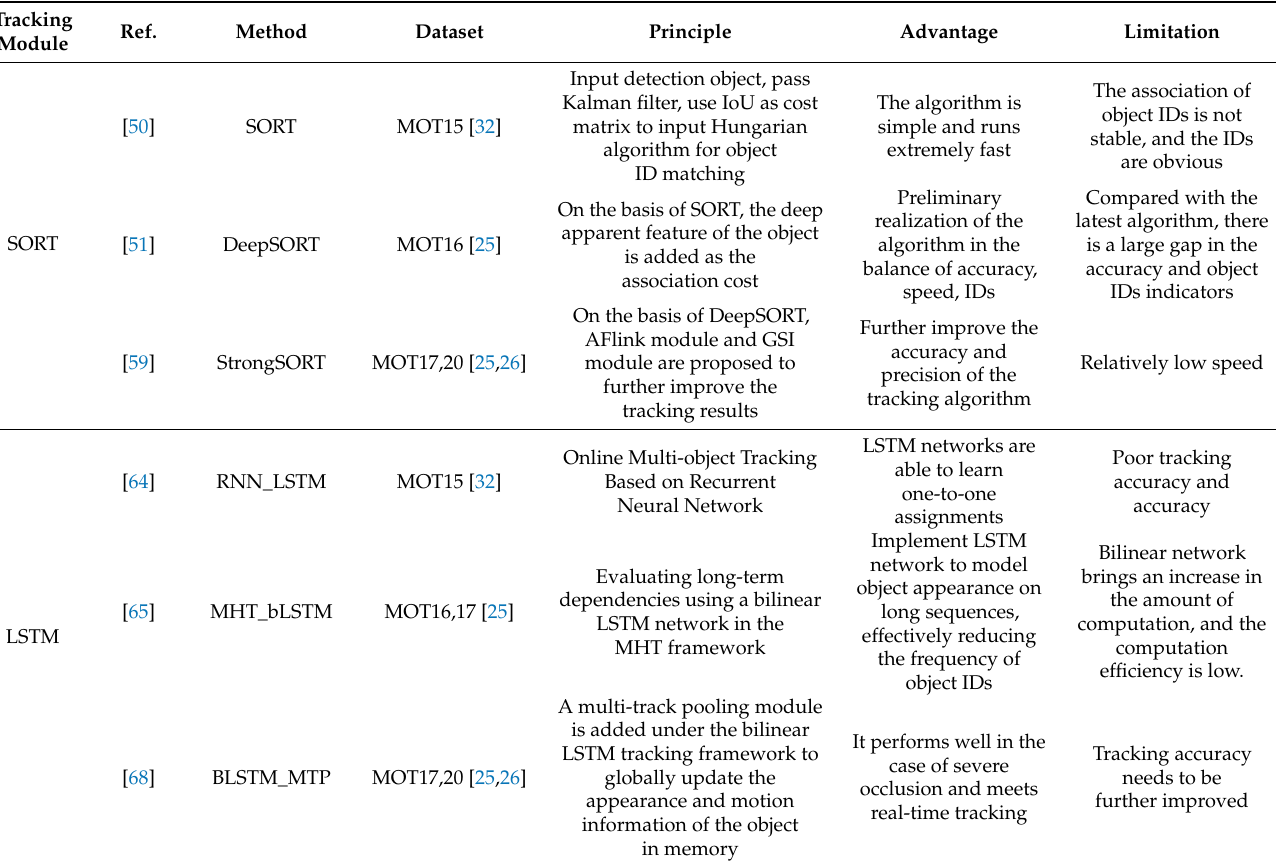
Table 5. Algorithm analysis and comparison based on TBD